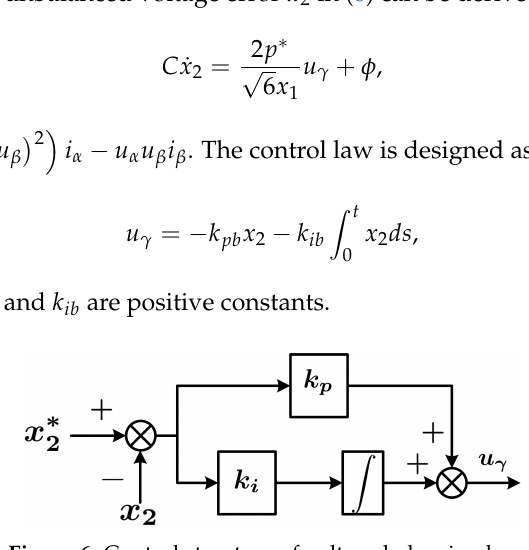
Figure 6. Control structure of voltage balancing